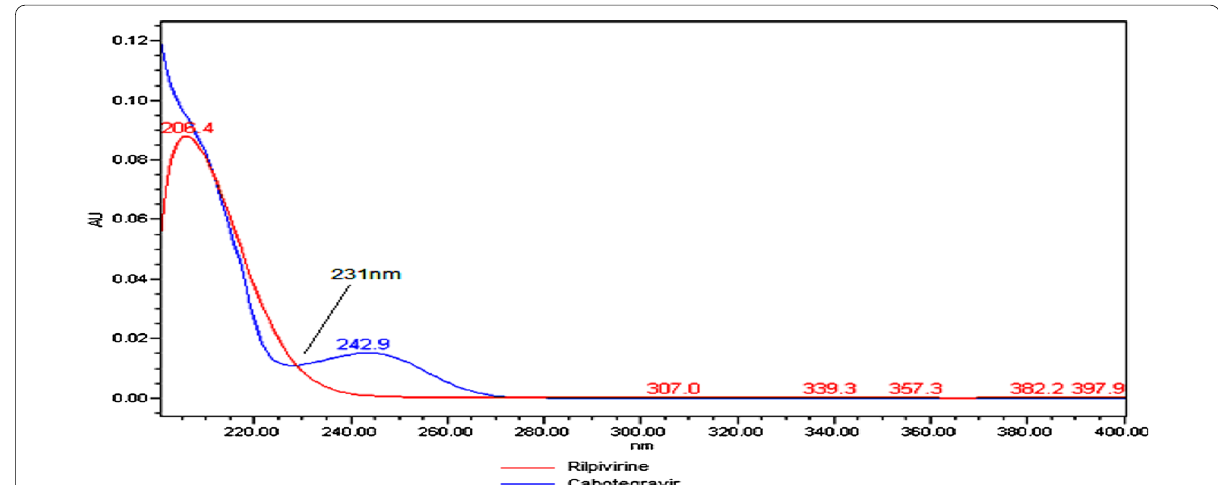
Fig. 2 Photodiode array detector spectrum of Cabotegravir and Rilpivirine